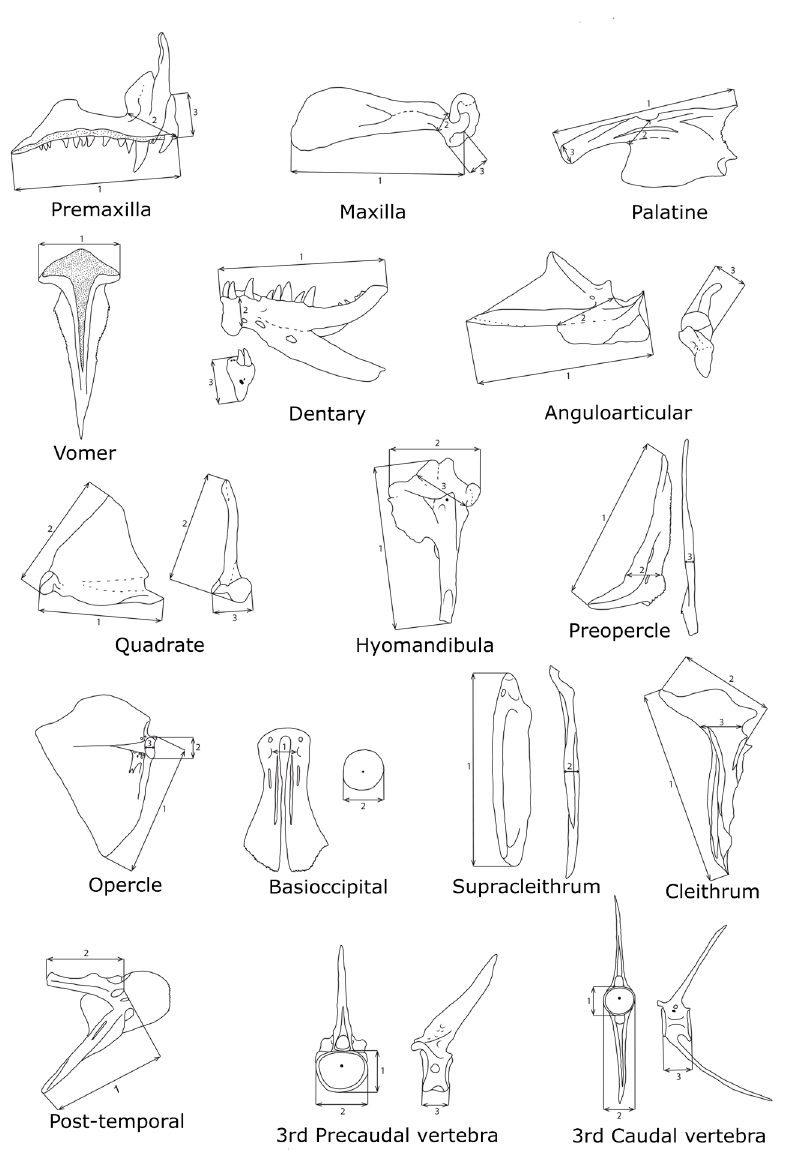
FIGURE 2 | Lutjanus argentiventris bone